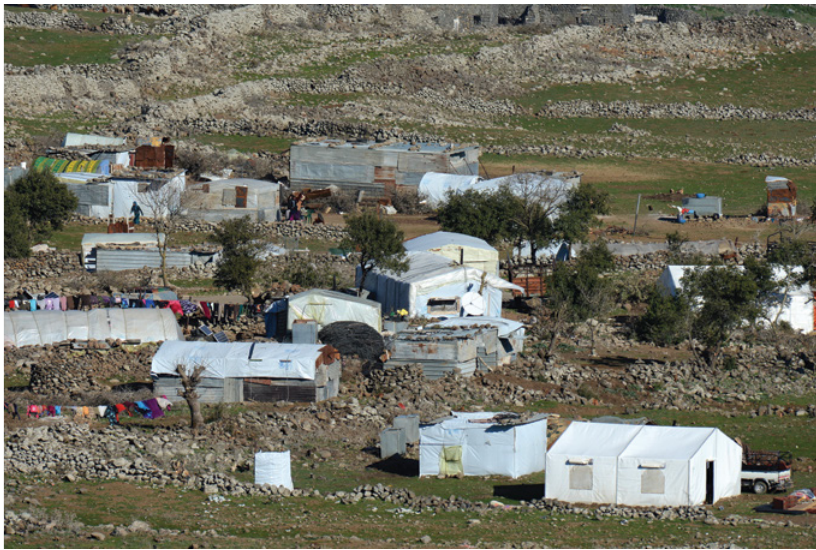
Figure 4. View of a refugee camp on the Syrian side of the Israeli-Syrian border, in the Golan Heights near the Syrian village of Briqa, east of Quneitra, February 17, 2016. Photo by Ancho Gosh and Gil Eliyahu – JINIPIX